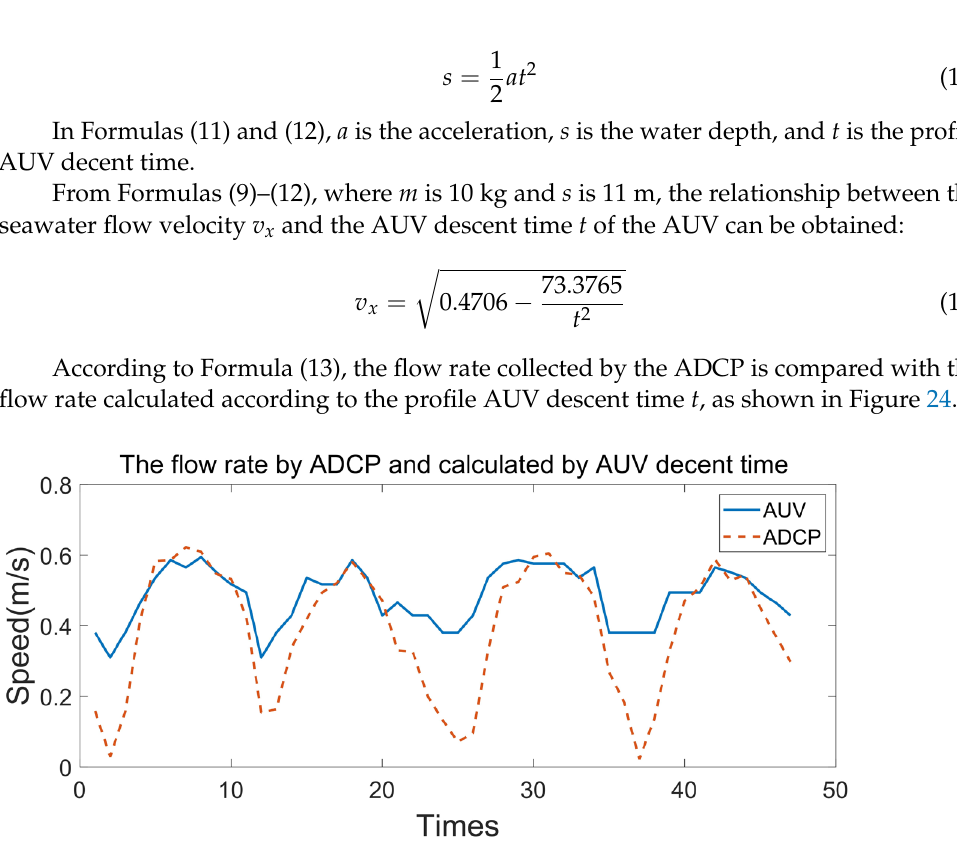
Figure 24. Flow rate using the ADCP and calculated using the AUV descent time.